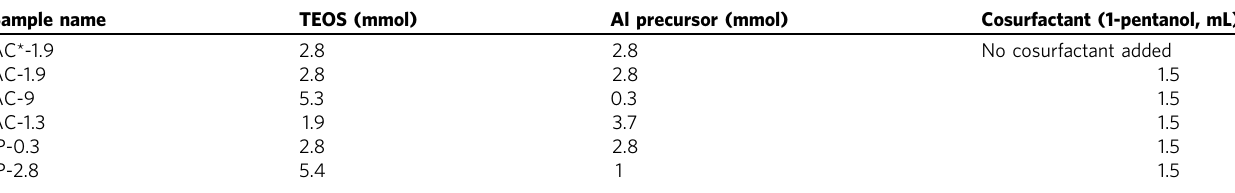
Table 2 Moles of TEOS and Al precursor for the synthesis of AAS with various Si/Al ratios. Sample name TEOS (mmol) Al precursor (mmol)